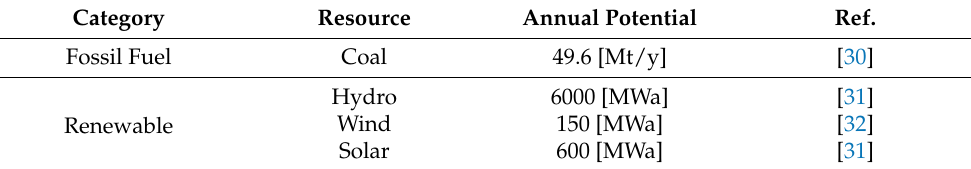
Table 5. Resource availability.